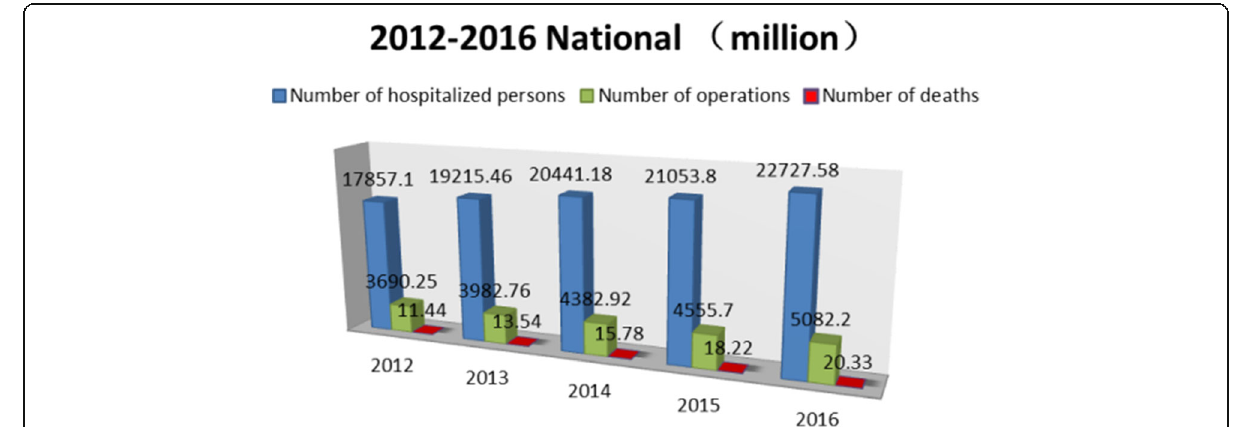
Fig. 1 2013 – 2017 national medical service